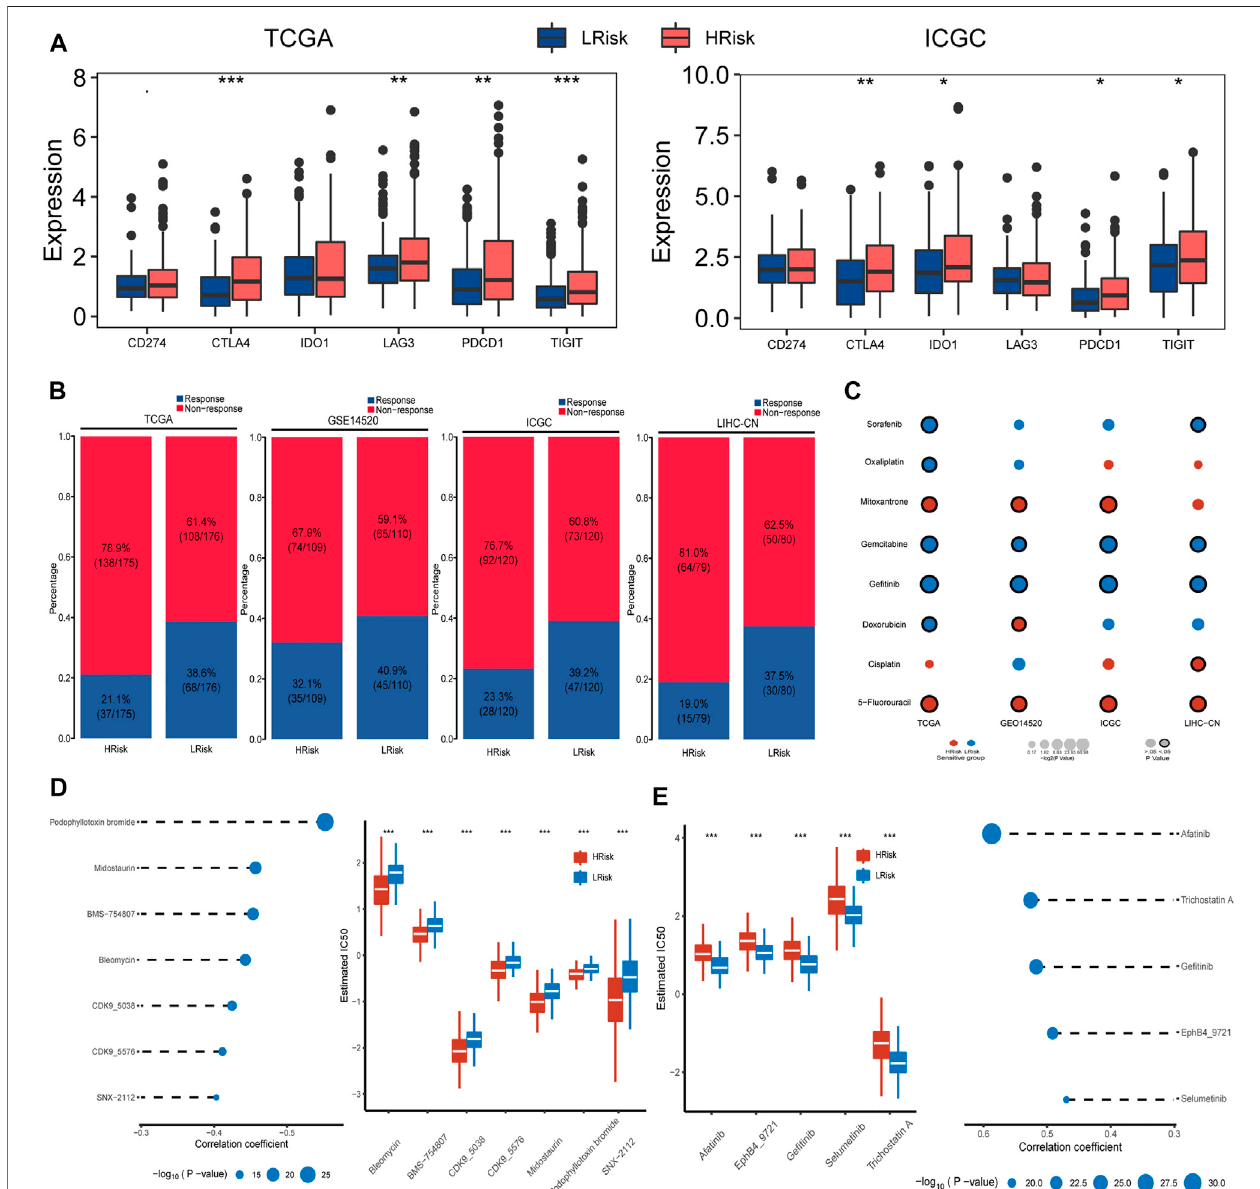
FIGURE 5 | Differential sensitivity to immunotherapy and chemotherapies between HRisk and LRisk. (A) Boxplot for TCGA and ICGC cohort showing the different expression levels of six immune checkpoint genes between riskgroups. Statistical p values were calculated by the Wilcoxon test and represented by. < 0.1, * < 0.05, ** < 0.01,and*** < 0.001. (B) BarplotsrevealedthatLRiskmightbemorelikelytoresponsetoimmunotherapythanHRiskinTCGA(Chi-squaretest, p < 0.001),GSE14520 (Chi-square test, p = 0.23), ICGC (Chi-square test, p = 0.012), and LIHC-CN (Chi-square test, p = 0.016) cohorts, respectively. (C) Bubble plot showing the drug sensitivity for eight commonly used chemotherapeutic drugs in liver cancer between HRisk and LRisk across four cohorts, where red and blue bubbles show that either HRisk or LRisk group is more sensitive to a drug according to the corresponding mean value of predicted IC 50 ; and a black circle wrapped around the bubble presents whether a statistically signi fi cant difference is achieved. Statistical p values were calculated by the Wilcoxon test. (D) The results of Spearman ’ s correlation analysis and boxplotsforthedistributionofsevenHRisksensitivitydrugsresponseanalysesinTCGAdatasets. (E) TheresultsofSpearman ’ scorrelationanalysisandboxplotsforthe distribution of fi ve LRisk sensitivity drugs response analyses in TCGA